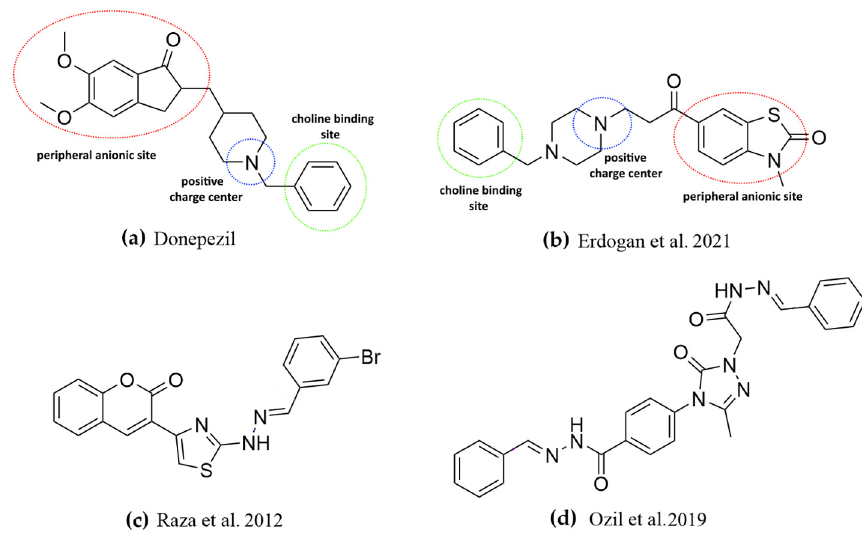
Figure 1. Structural hypothesis for ChE inhibitors illustrated on donepezil ( a ) and a bezothiazolone derivative ( b ) and ChE inhibitor Schiff base derivatives ( c , d ).